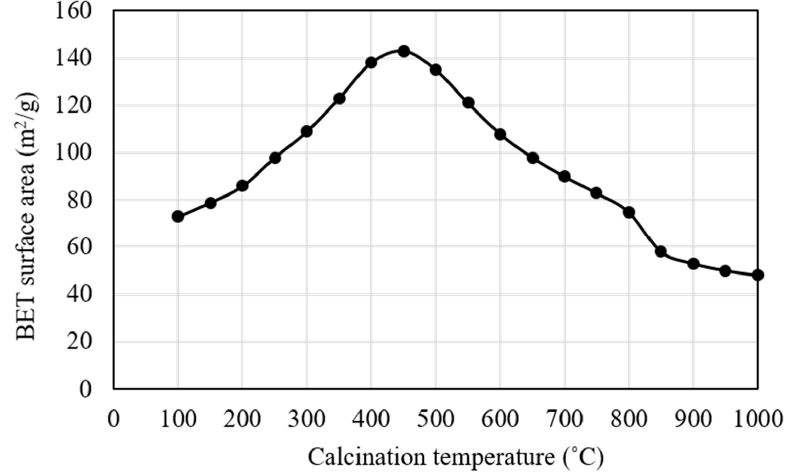
Figure 4. The Brunauer-Emmett-Teller (BET) surface area of Pd 0.016 Mg 3 Al(OH) 16 CO 3 · x H 2 O on calcination temperature from 100 °C to 1000 °C.